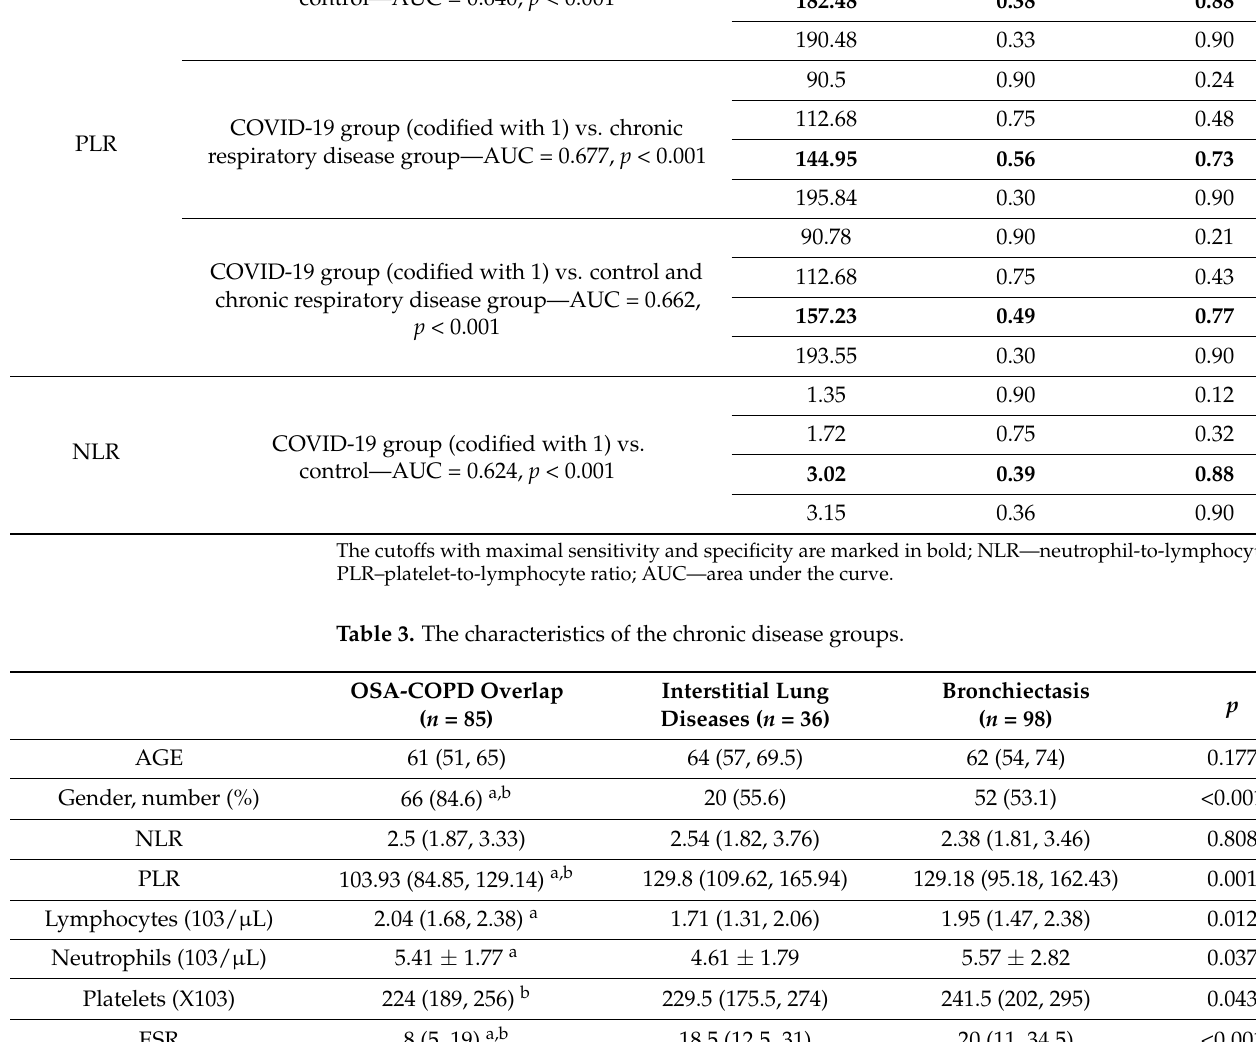
NLR was found to be poor, but statistically significant as a diagnostic test when we compared the control group with all three groups (separately): the OSA-COPD group (coded with 1) (Figure 2a); interstitial lung disease group (Figure 2c); and bronchiectasis group (Figure 2e). When we compared the diseases, NLR failed and was not statistically sig- nificant in any of the comparisons: the OSA-COPD group (coded with 0) versus interstitial lung disease and bronchiectasis groups (AUC = 0.507, p = 0.859) (Figure 2b); interstitial lung disease group (coded with 1) versus OSA-COPD and bronchiectasis groups (AUC = 0.534, p = 0.516) (Figure 2d); and bronchiectasis (coded with 1) group versus OSA-COPD and interstitial lung disease groups (AUC = 0.488, p = 0.756) (Figure